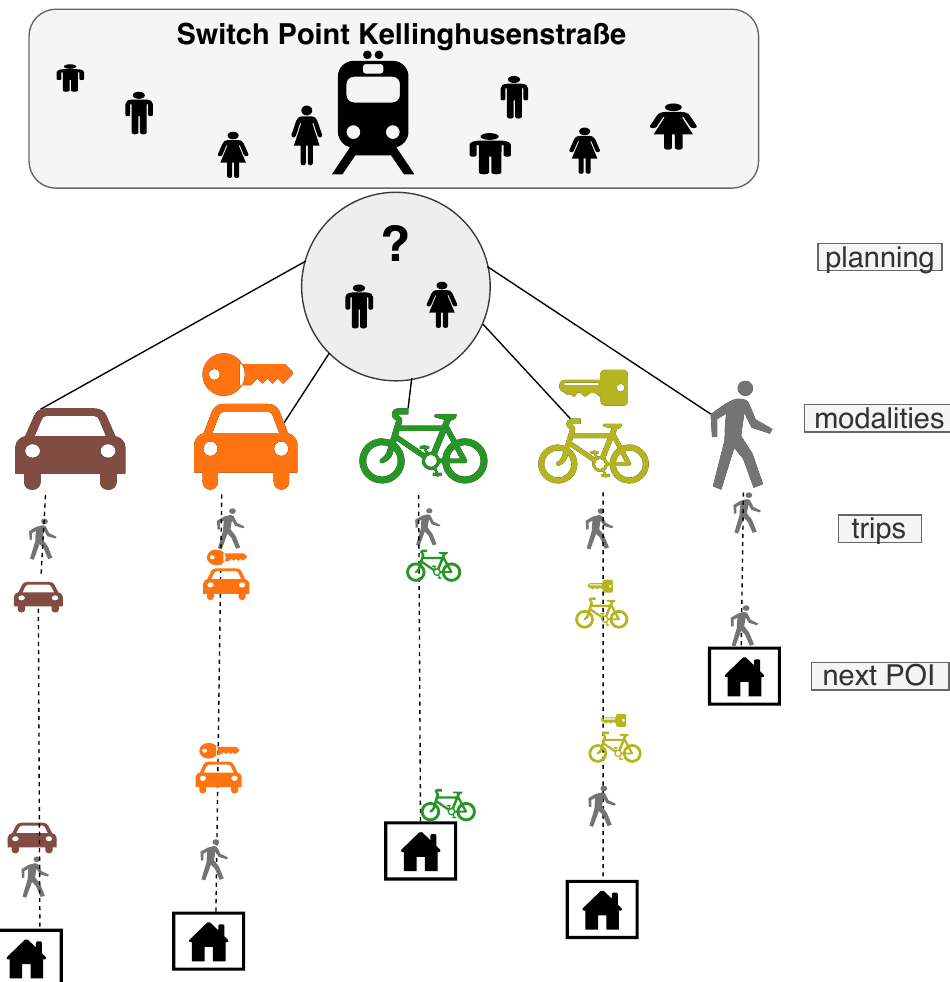
Figure 3. Available modalities and the path chains resulting from the available combinations of